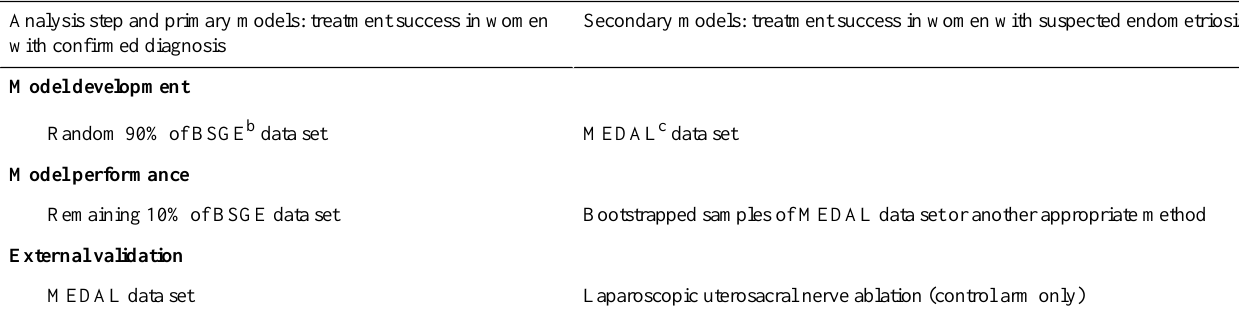
Table 1. CRESCENDO (Creating a Clinical Prediction Model to predict Surgical Success in Endometriosis) data sets and their planned use during analysis a